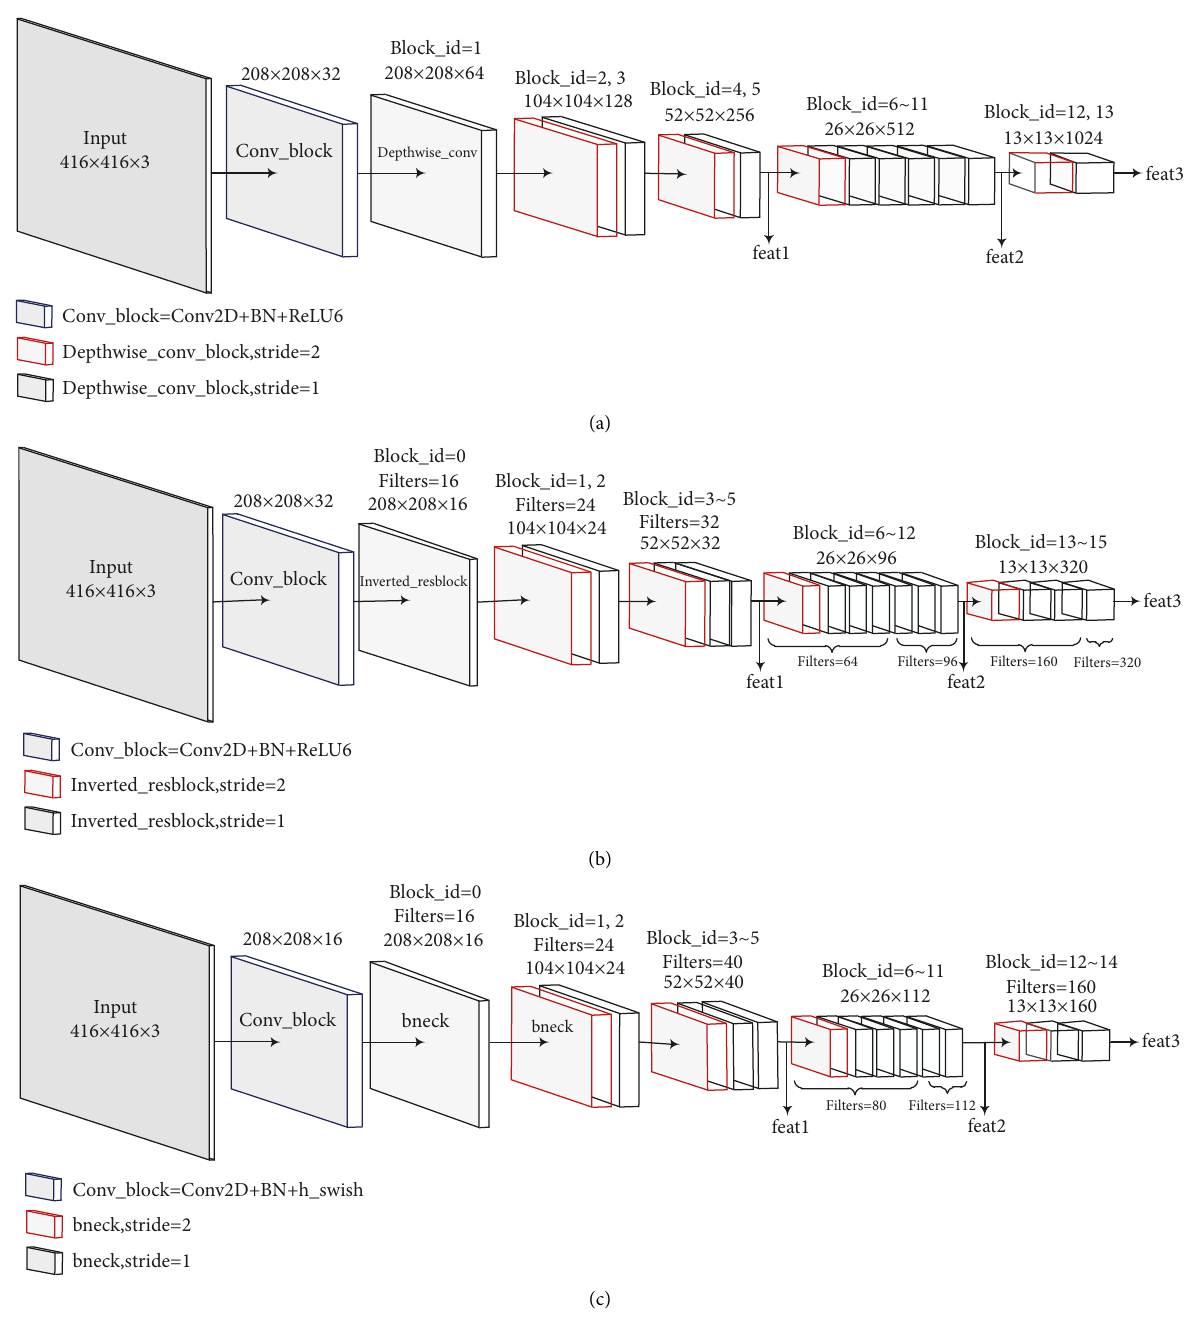
Figure 3: Schematic diagrams of the backbone structure of MYOLO-lite series. (a) Schematic diagram of MV1-YOLO-lite structure. (b) Schematic diagram of MV2-YOLO-lite structure. (c) Schematic diagram of MV3-YOLO-lite